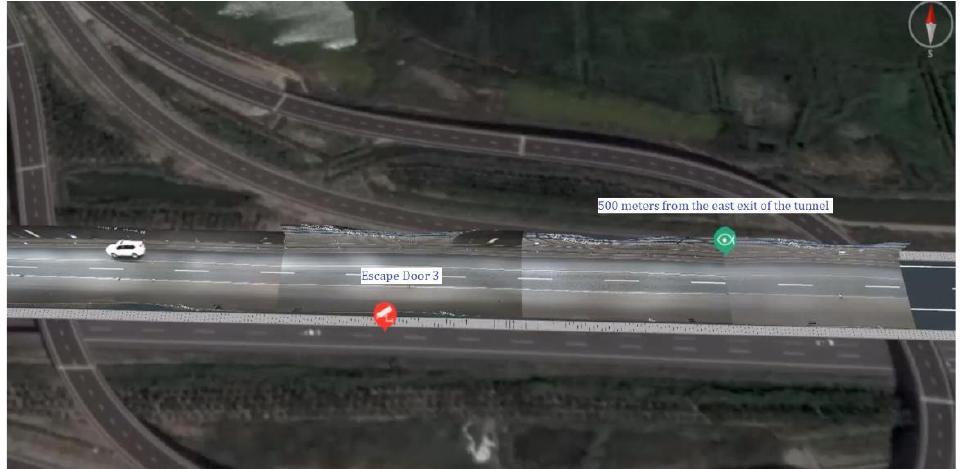
Figure 7. An example of tunnel asset and annotation data aggregation.